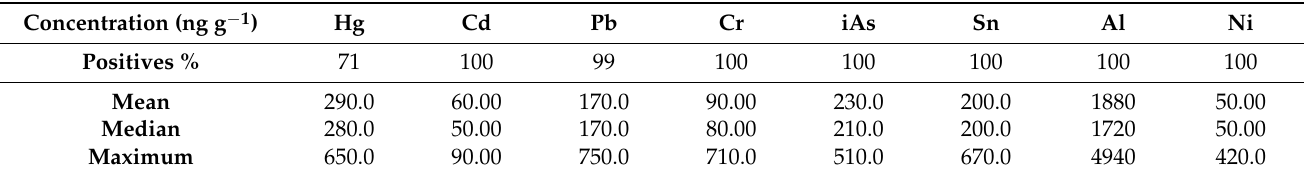
Table 5. Mean, median and maximum concentrations of elements detected in the anchovies.